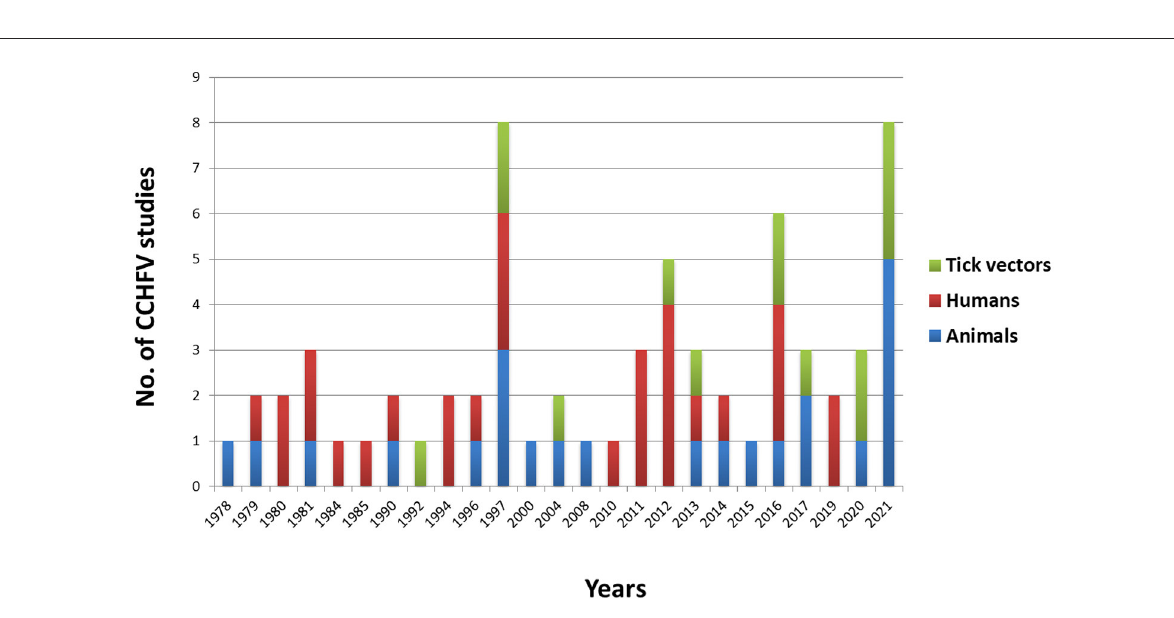
from published data that could be associated with CCHFV transmission (Table 1). Out of the 20 tick species, twelve belong to the genus Hyalomma , four belong to the genus